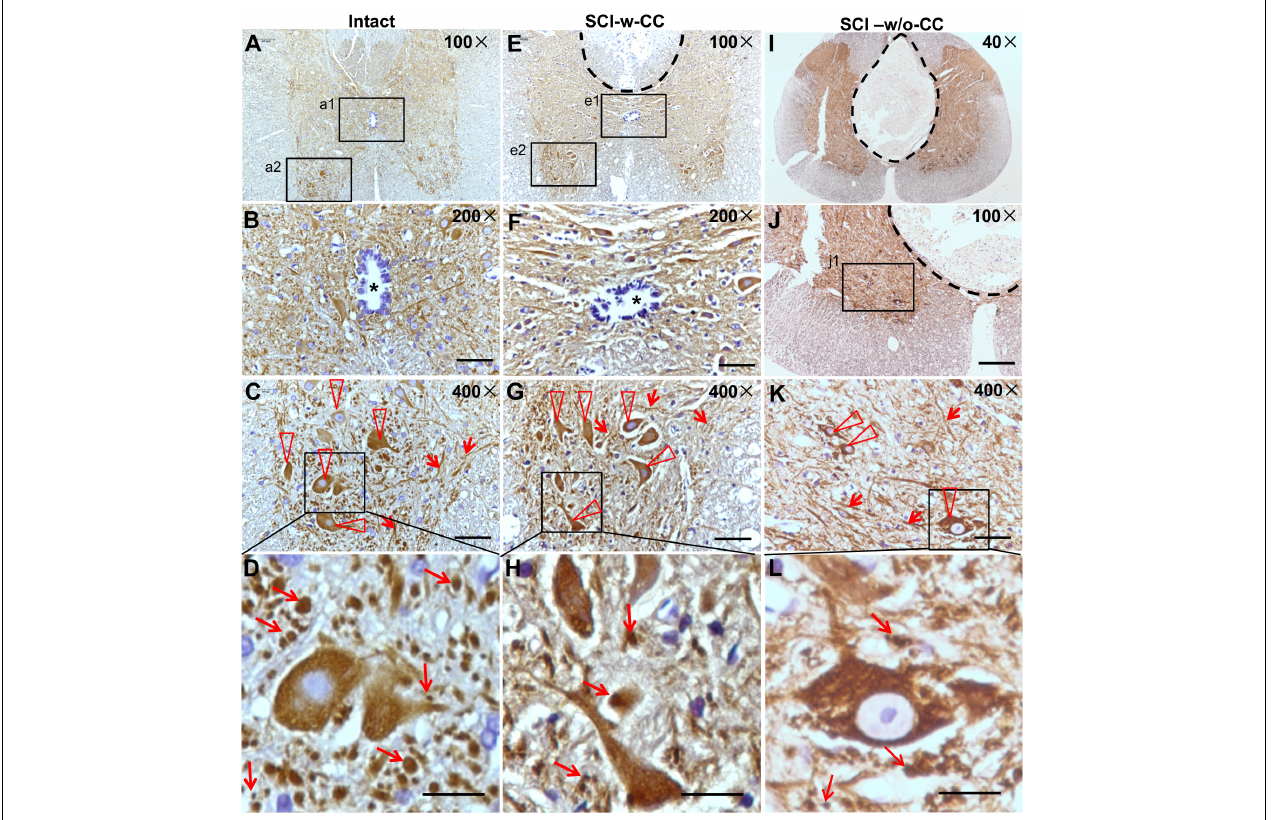
FIGURE 6 | The organization of SCECs were related to neuronal lesions in injured spinal cords. (A–D) Expression of beta-III-tubulin in intact spinal cord neurites. (B,C) Represent 200 × and 400 × magnifications of insets a1 and a2 shown in (A) , respectively. The asterisk in (B) indicates an intact CC. (D) Represents a ∼ 1730 × magnification of the inset shown in (C) . Beta-III-tubulin-positive motor neurons and neurites are indicated by triangles and arrowheads (C) . Beta-III-tubulin-positive neurites (CS-neurites) are indicated by arrows (D) . (E–H) Expression of beta-III-tubulin in injured spinal cord neurites. The region with a dashed line indicates the lesion site. (F,G) Represent 200 × and 400 × magnifications of insets e1 and e2 shown in (E) , respectively. The asterisk in (F) indicates a CC that is not damaged. (H) Represents a 1700 × magnification of the inlet shown in (G) . Triangles indicate motor neurons (G) while arrows indicate CS-neurites (H) . (I–L) Expression of beta-III-tubulin in the neurites of neurons in injured spinal cords in which the CCs were damaged. (L) Represents a higher magnification of the inset shown in (K) . Scale bars: 50 µ m (B,F) , 100 µ m (J) , 25 µ m (C,G,K) , and 10 µ m (D,H,L) . Triangles indicate motor neurons (K) and arrows indicate CS-neurites (K,L)